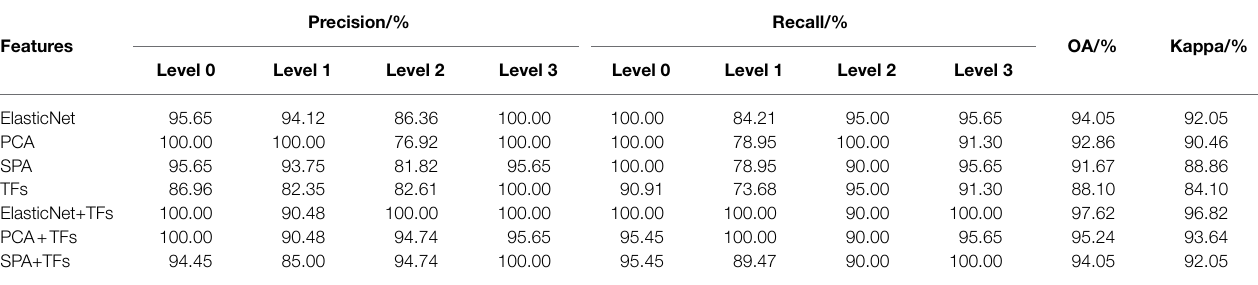
TABLE 7 | Modeling results of AIPSO-ELM algorithm.